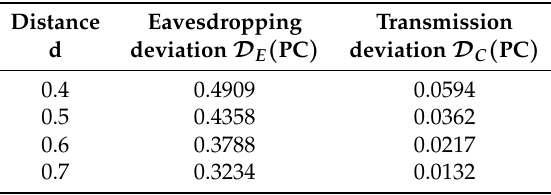
Table 4. Eavesdropping deviation and transmission deviation of comparing FJ-PC scheme with Non-Jam scheme when T = 10 dB, ζ = 10 and α =